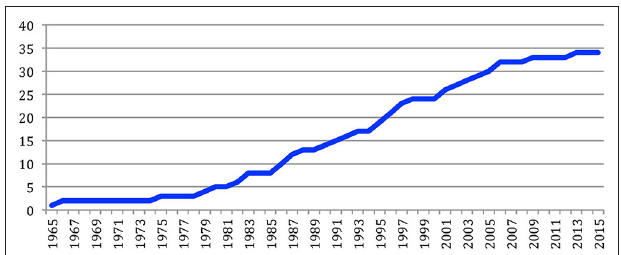
FIGURE 4 | Cumulated number of different sources (conferences and journals) over the years.